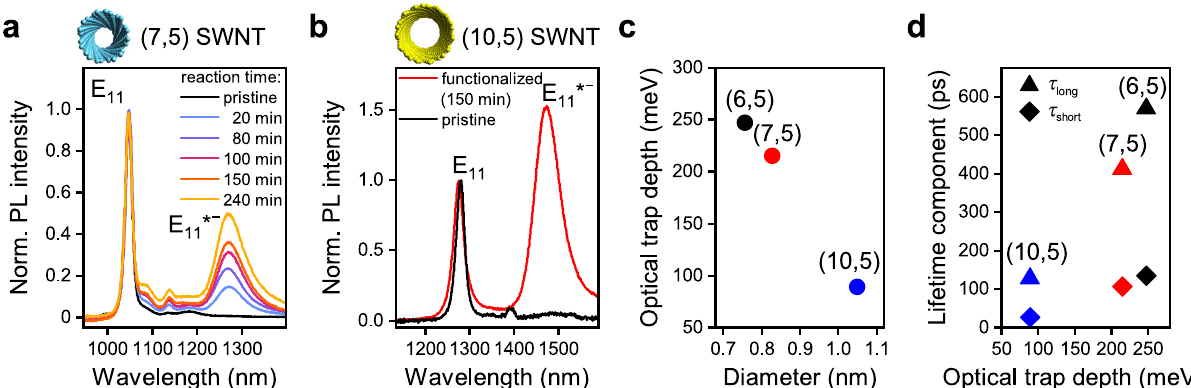
Fig. 4 Functionalization of polymer-wrapped SWNTs with larger diameters. a PL spectra of PFO-wrapped (7,5) SWNTs functionalized with 2-iodoaniline in the dark after different reaction times with a red-shifted E 11 * − emission band (~1270 nm). b PL spectra of F8BT-wrapped pristine (10,5) SWNTs and functionalized with 2-iodoaniline in the dark for 150 min. Functionalization gives rise to a red-shifted E 11 * − emission band (~1474 nm). The concentration of 2-iodoaniline was kept at 29.30 mmol L − 1 . c Optical trap depths of E 11 * − defect states as a function of SWNT diameter. d E 11 * − defect fl uorescence lifetimes (long and short) depending on optical trap